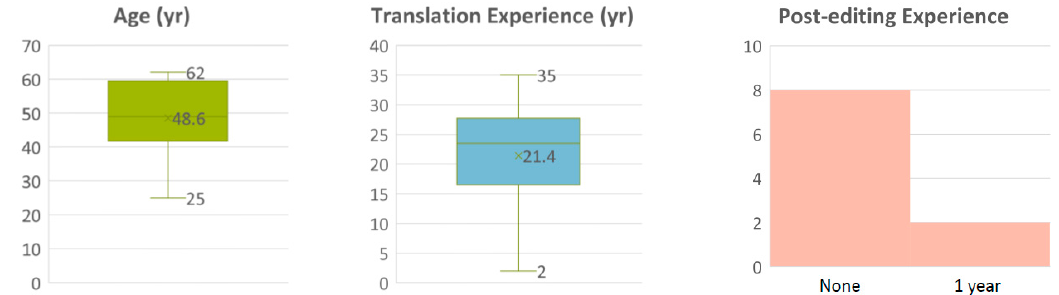
Figure 5. Participants’ demographics: age, translation experience, and postediting experience.